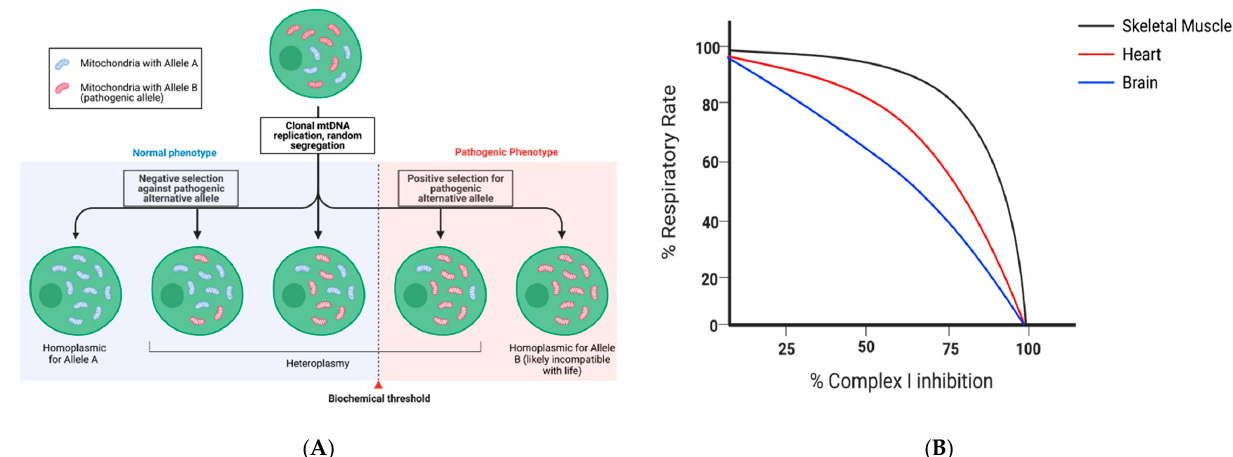
Figure 1. ( A ): Mitochondrial segregation can result in a spectrum of progeny, which harbor a range of mtDNA variants dependent upon random segregation and/or positive and negative environmental selective pressures. Notably, time may influence the segregation process, including biological age. ( B ): While the biochemical threshold shown in 1A is static, the true biochemical threshold for heteroplasmic variation functionally affecting the tissue varies by tissue type. Data adapted from [23]. Figures created with biorender.com (accessed on 10 October 2021).